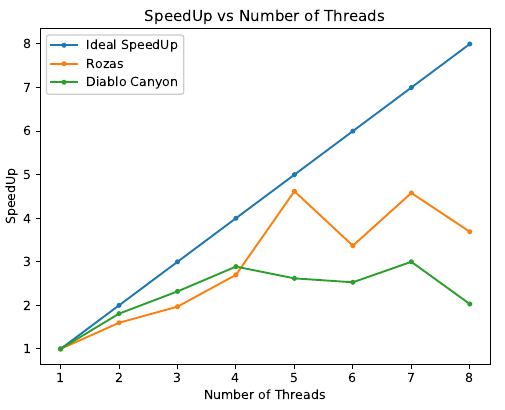
Figure 10. Speed Up values for different number of threads.